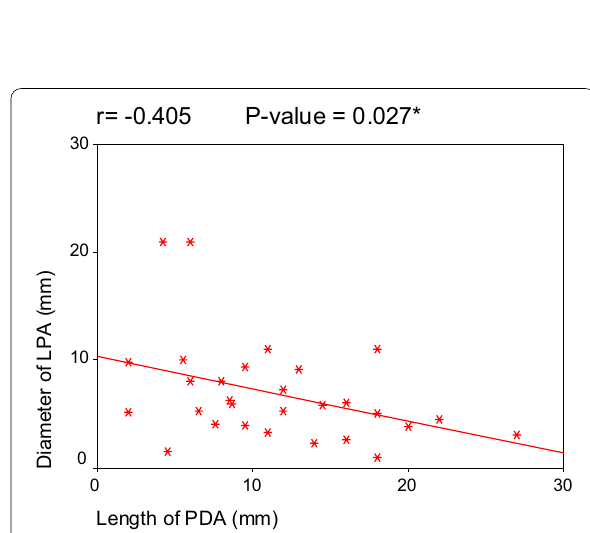
Fig. 7 Spearman’s correlation between length of PDA and diameter of LPA